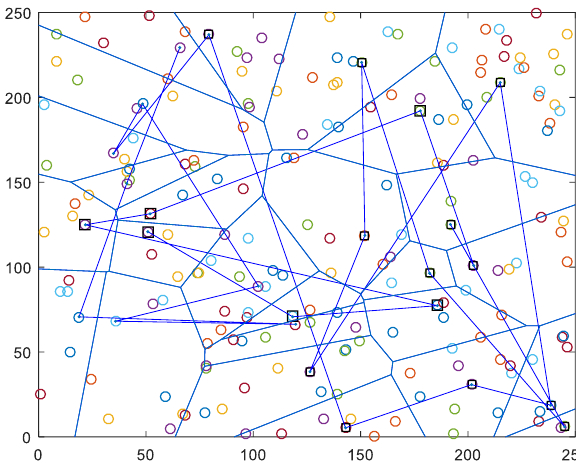
Figure 15. Simulation of the mobile sink trajectory.